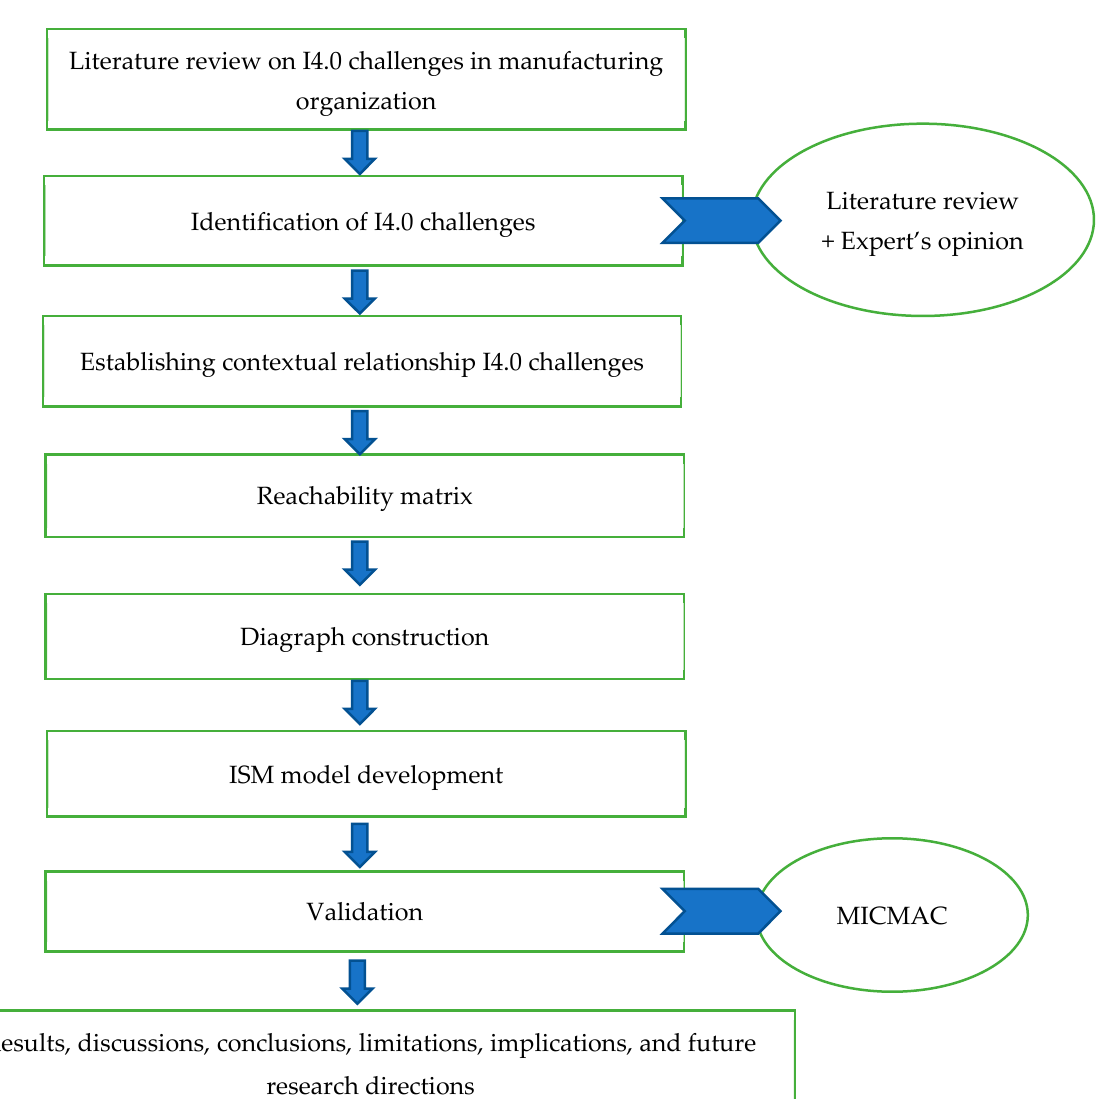
Figure 1. Flowchart of the study.